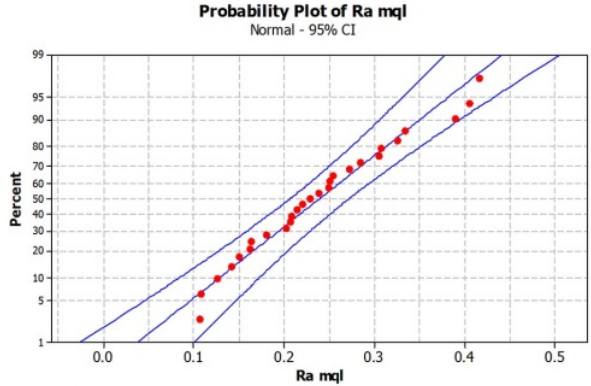
Figure 4. The probability plot of surface roughness under MQL conditions.